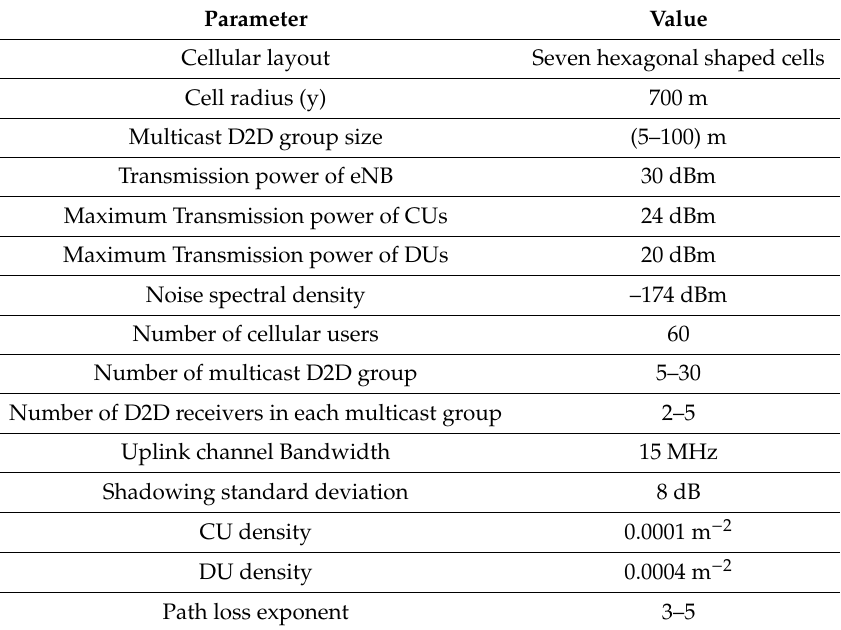
Table 1. Main simulation parameters and